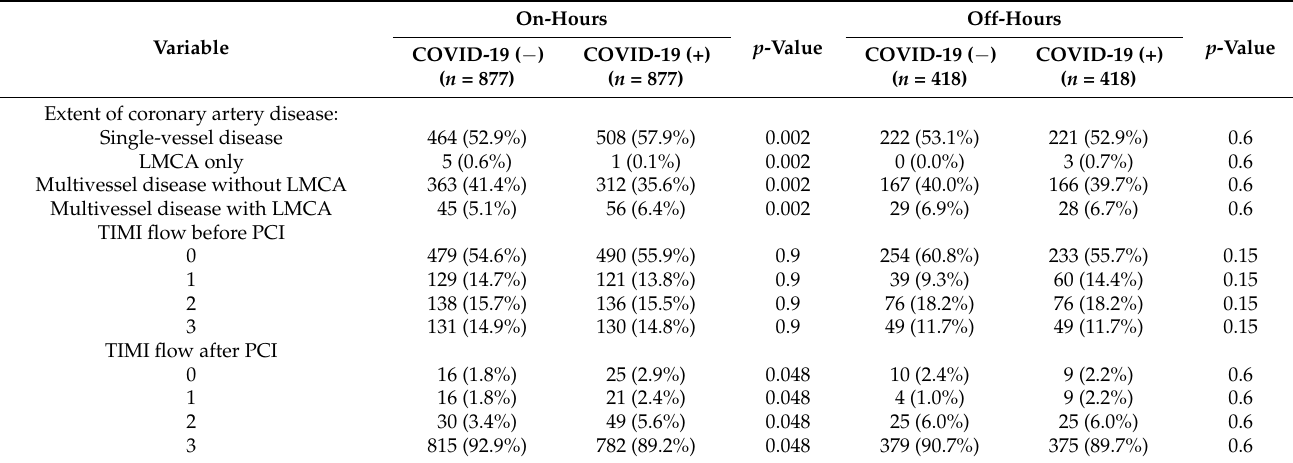
Table 2. Angiographic characteristics after propensity score